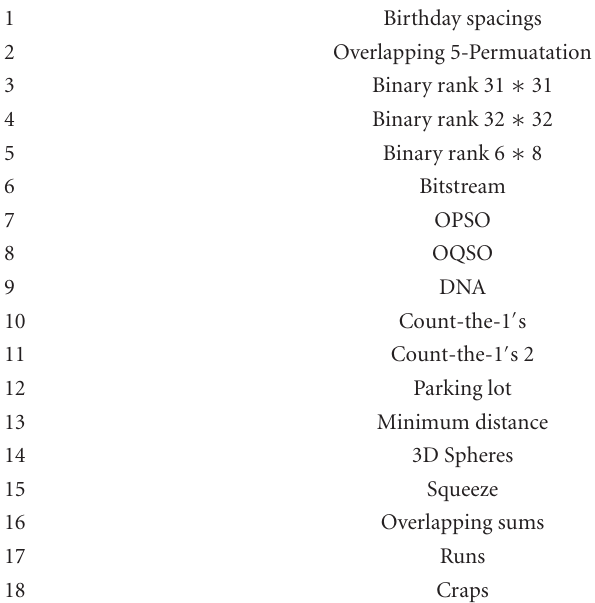
Table 5: Diehard